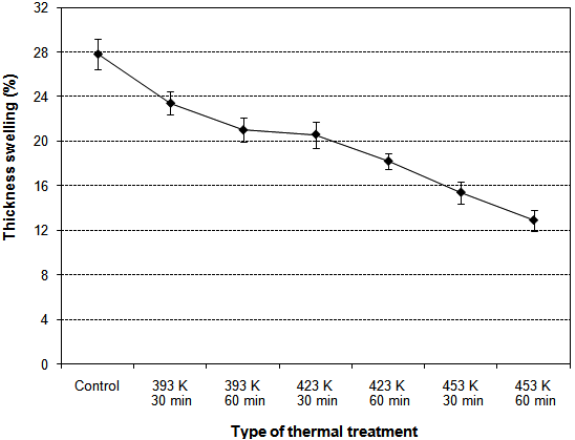
Figure 1. Effect of the thermal treatment of the wood fibers of eucalyptus camaldulensis on the thickness swelling of the light MDF panels. The vertical lines through the bars represent the standard deviation from the average value of fifteen